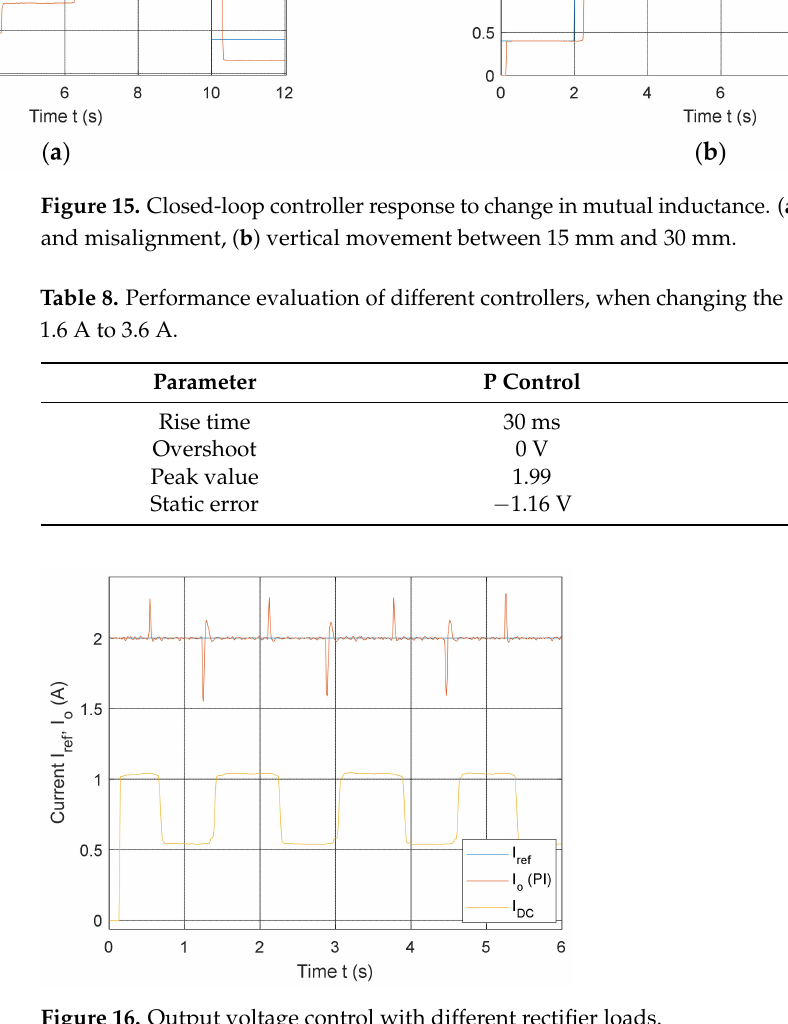
Figure 16. Output voltage control with different rectifier